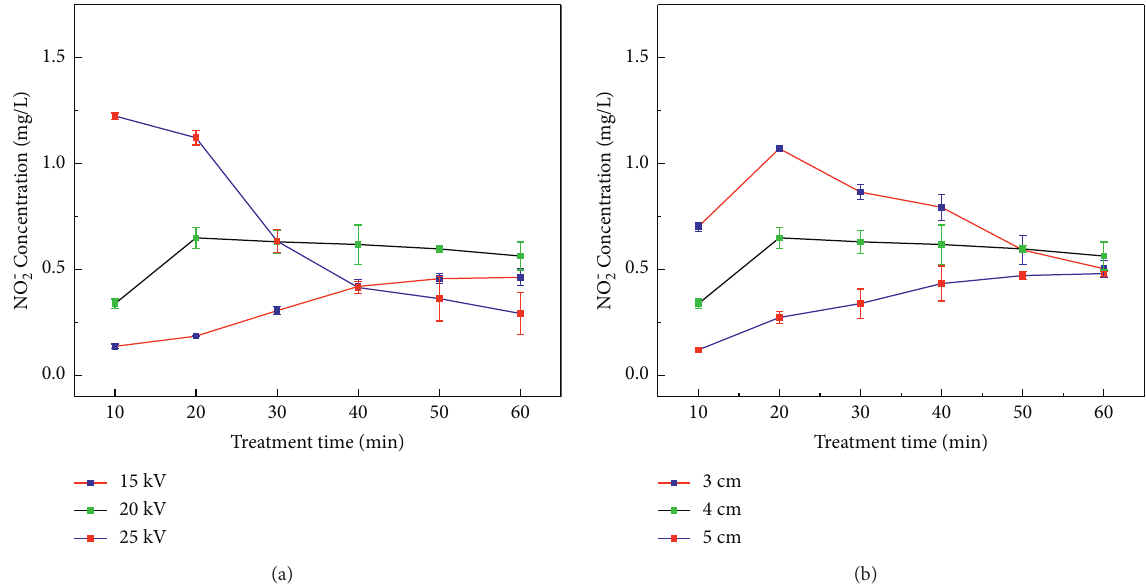
Figure 13: NO − concentrations at (a) voltages of 15, 20, and 25kV and the needle-dielectric plate distance of 4cm and (b) the needle- 2 dielectric plate distance of 3, 4, and 5cm and voltage of 20